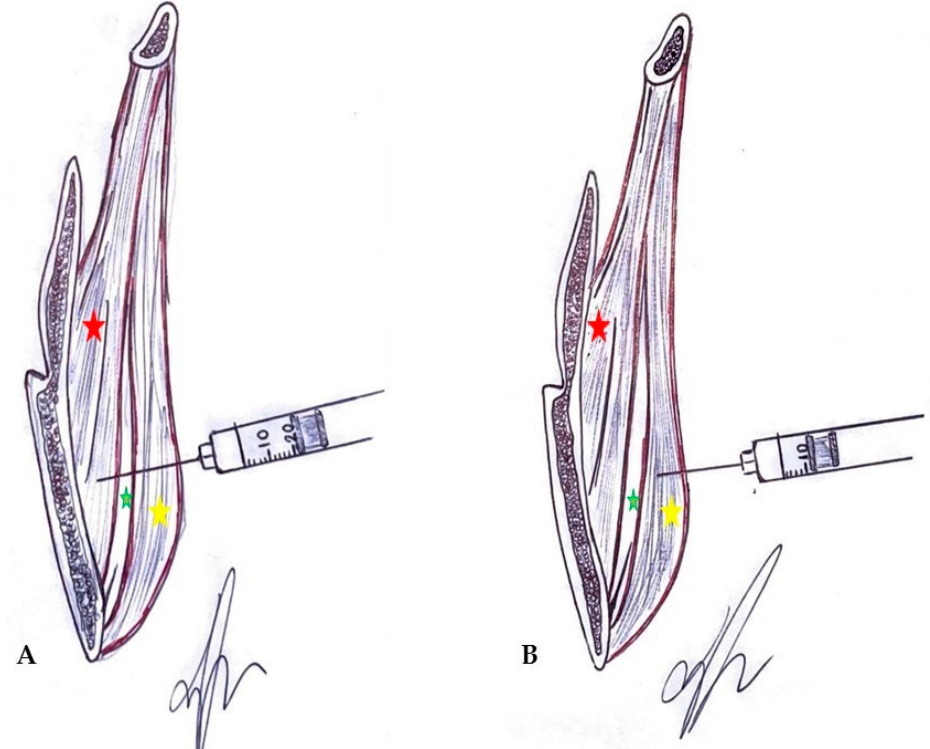
Figure 3. Biphasic injection technique. ( A ) 0.1 mL were released into the deep belly of the masseter muscle (red star). ( B ) 0.1 mL were released on the superficial belly (yellow star) of the masseter muscle at the same site injection. The deep inferior tendon (green star) divides the masseter muscle into two layers.